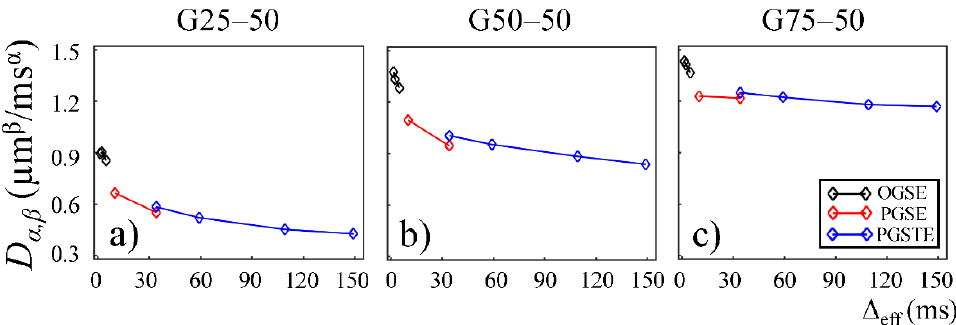
Figure 3. Plots of D α,β versus effective diffusion time, Δ eff , for gels G25 – 50 ( a ) and G50 – 50 ( b ), and G75 – 50 ( c ) with increased macromolecular exclusion limit. The data acquired by using the OGSE, PGSE, and PGSTE pulse sequences are marked in black, red, and blue, respectively.